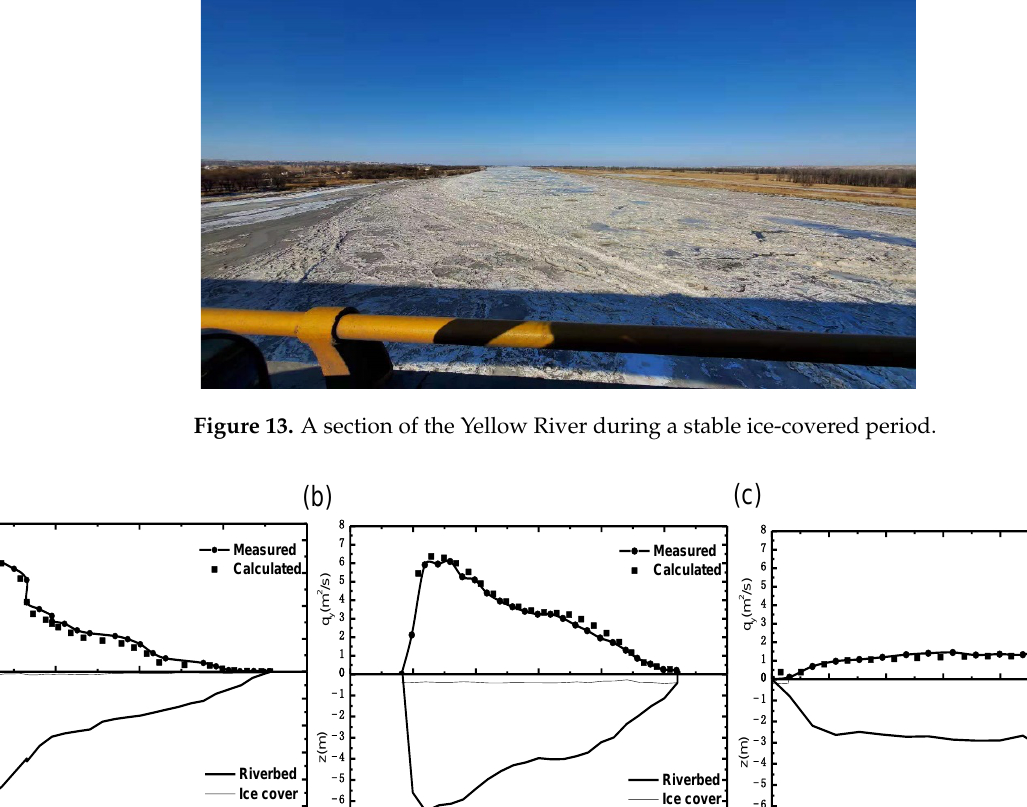
Figure 13. A section of the Yellow River during a stable ice-covered period.